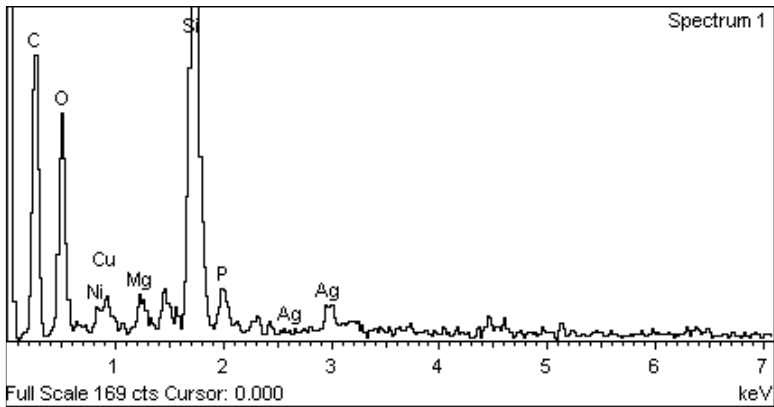
Figure 2. Energy dispersive X-ray analysis results of the studied industrial dust. Table 2. Composition of the industrial dust used in the study.